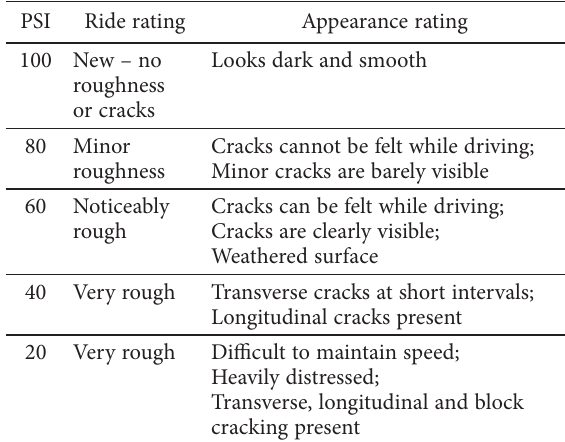
Table 1. PSI rating